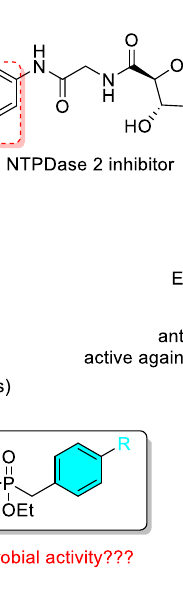
Figure 1. Biologically active diethyl benzylphosphonate derivatives.